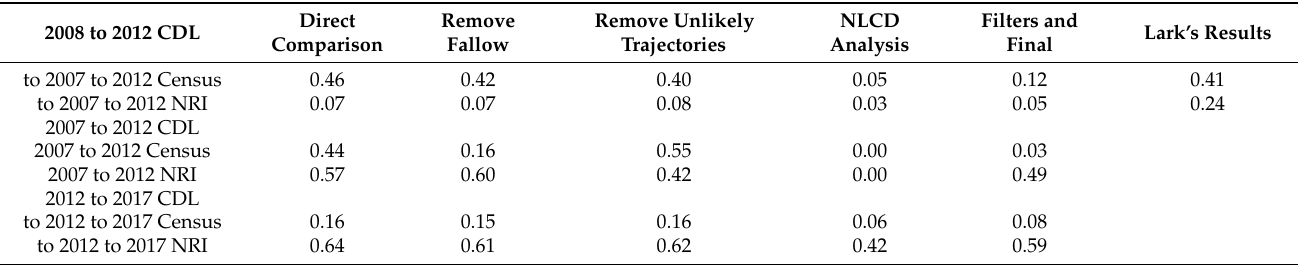
Table 4. Coefficients of determination for Estimated Net Change in Cropland for the CDL compared to the NRI and Census for different year intervals before and after the CDL has post-classification refinement techniques